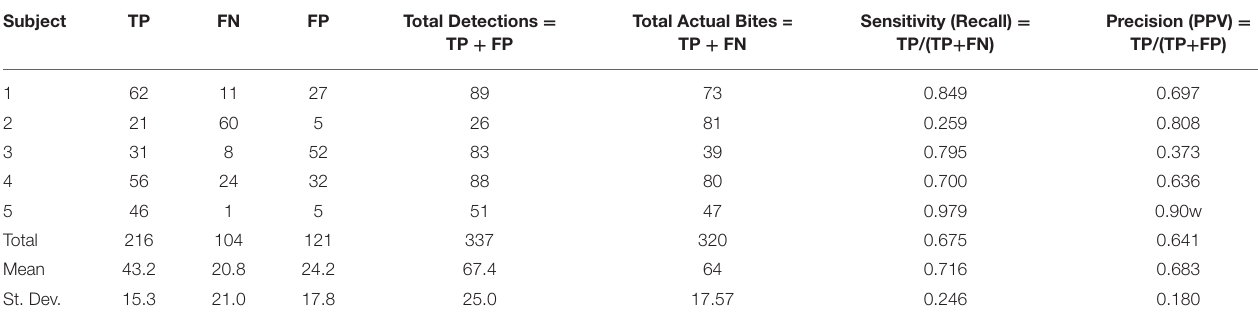
TABLE 1 | Three-plate experiment bite detection results.